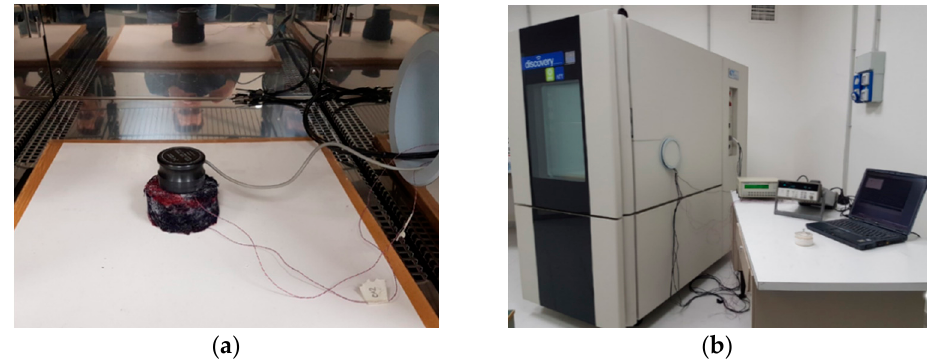
Figure 8. Measurement setup of thermal properties: ( a ) the sample inside the climatic chamber; ( b ) the ISOMET 2104, Agilent 34970A data acquisition unit and notebook outside the climatic chamber.